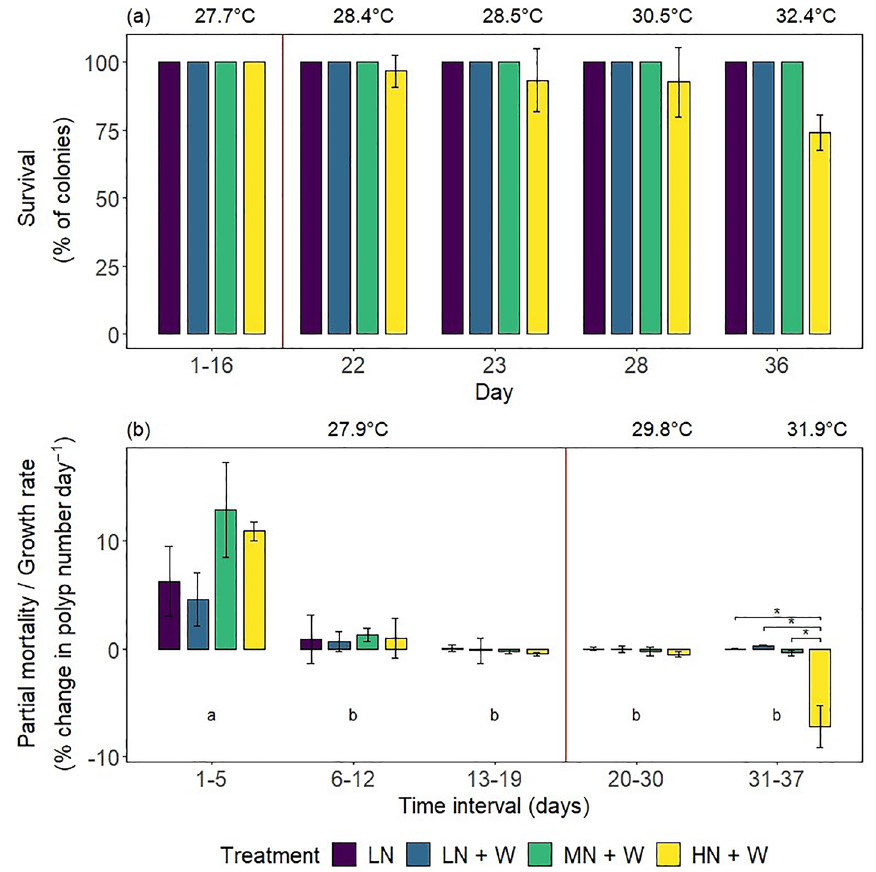
Figure 2. ( a ) Percent survival and ( b ) growth rates of Xenia umbellata colonies from control tanks with low nitrate (LN, ~ 0.6 μM) and three treatments: LN + W = low nitrate (~ 0.6 μM) + warming from day 17; MN + W = medium nitrate eutrophication (~ 6 μM) + warming from day 17; HN + W = high nitrate eutrophication (~ 37 μM) + warming from day 17. Error bars represent standard deviations of three replicates. Temperatures represent mean temperatures of the respective days or intervals, excluding controls. Different letters in ( b ) indicate significant differences between days (pwc, Bonferroni adjustment, t -test, p < 0.05). Asterisks indicate significant differences between treatments within days (pwc, Bonferroni adjustment, t -test, * = p < 0.05). For ( a ), only days with recorded colony mortalities were plotted (except day 1–16). No post-hoc analysis could be performed for ( a ) due to lack of variance within groups where all replicate tanks displayed 100%